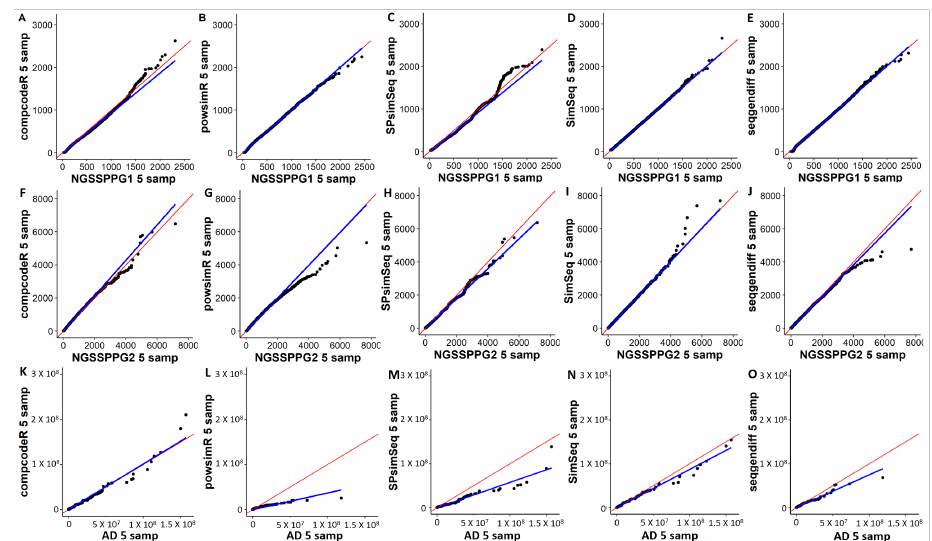
Figure 3. Q-Q plots of five synthetic data samples generated by the respective data generators (y axis) vs. five samples used as input for those data generators (x-axis), with ( A – E ) NGSSPPG1 samples used as input data; ( F – J ) NGSSPP2 samples as input data; ( K – O ) AD samples as input data. The axes represent the quantiles of the respective distributions. Blue: linear regression line. Red: diagonal line.